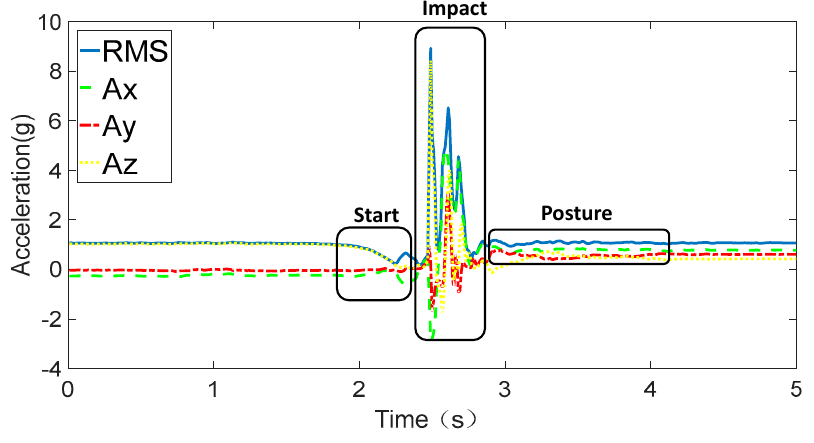
Figure 6. Root mean square (RMS) during a fall activity.